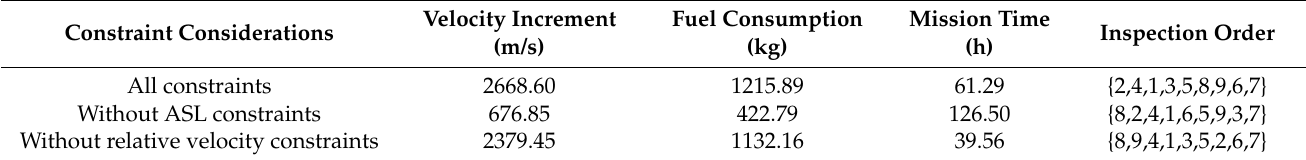
Table 7. The results of minimum velocity increment under different